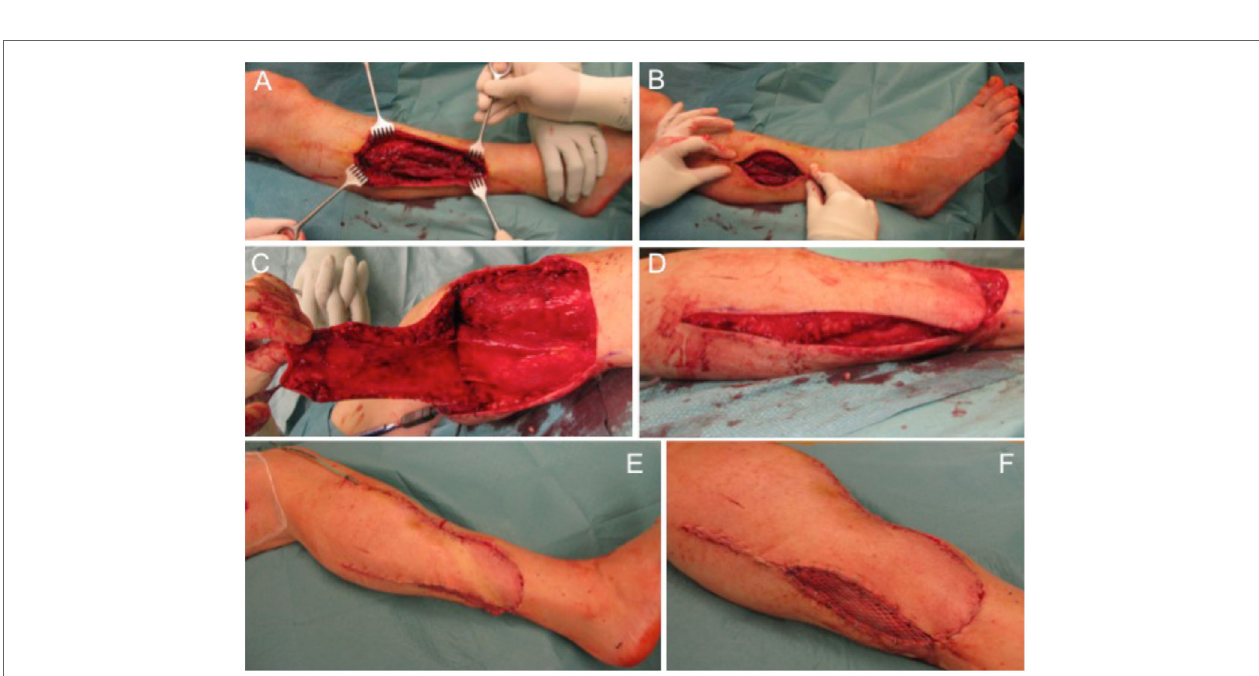
FiGURe 4 | Defect of the lower leg after tumor removal (A) with remaining defect at the lateral side (B) . A fasciocutaneous transposition flap is raised (C) and transferred ventrally into the defect (D) . Full coverage can be achieved (e) and remaining areas at the donor side can be transplanted with split thickness skin graft (F) .